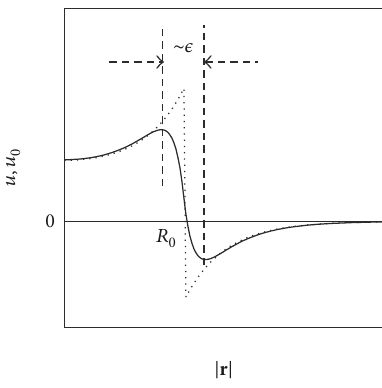
Figure 1: Boundary layer and interface. The solid and dotted curves correspond to 𝑢( r ,𝑡) and 𝑢 0 ( r , 𝑡) = lim 𝜖→0 𝑢( r ,𝑡) along a radial direction, respectively, that is, 𝑢(| r |, 𝑡) and 𝑢 0 (| r |, 𝑡) . In the finite 𝜖 , 𝑢(| r |,𝑡) has a boundary layer around | r | ∼ 𝑅 𝜖 , where 𝑅 0 is determined by the condition does not have a boundary layer but has a sharp interface at | r | = 𝑅 0